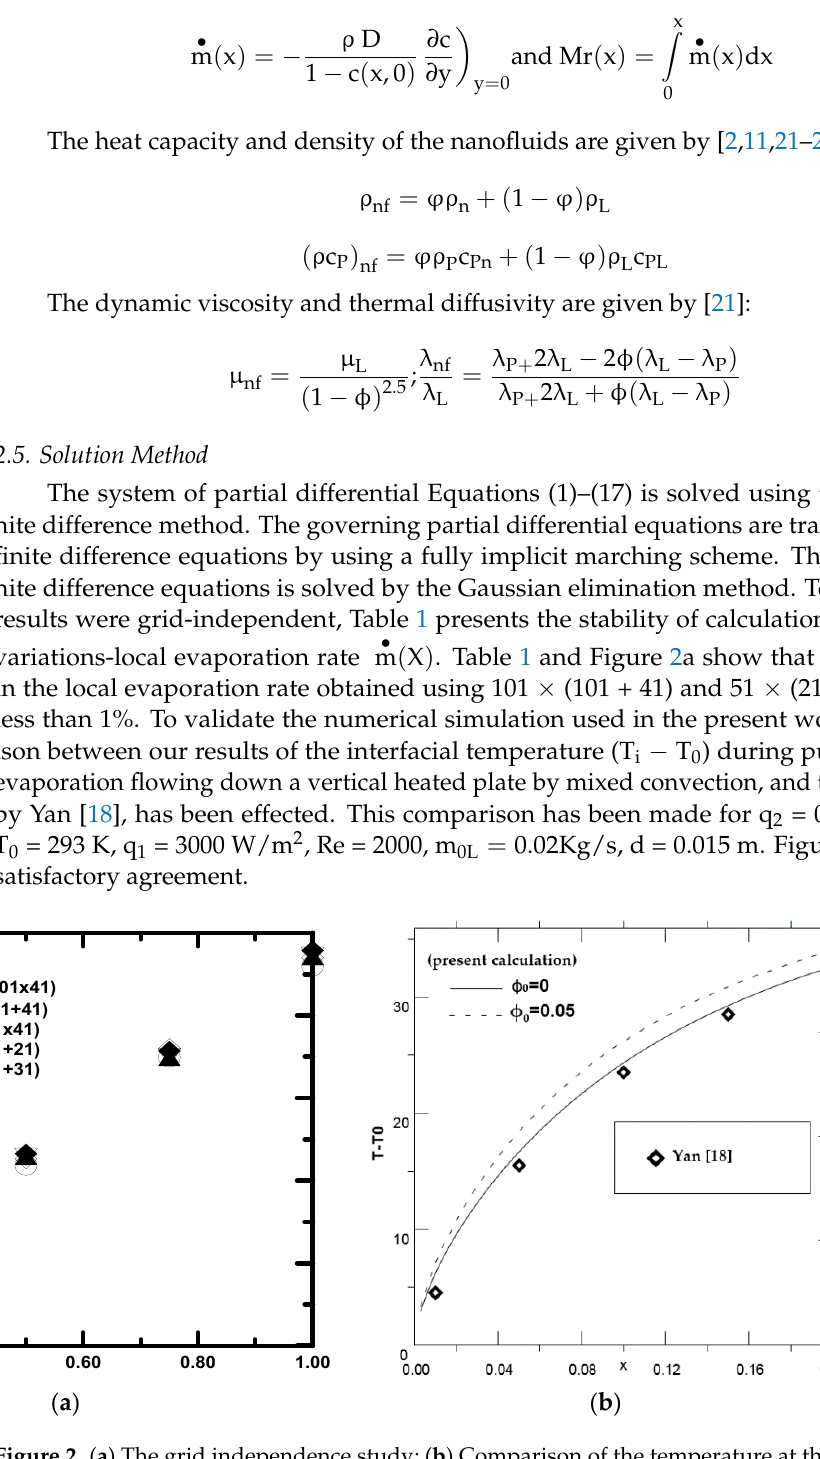
Figure 2. ( a ) The grid independence study; ( b ) Comparison of the temperature at the interface with Yan [18].